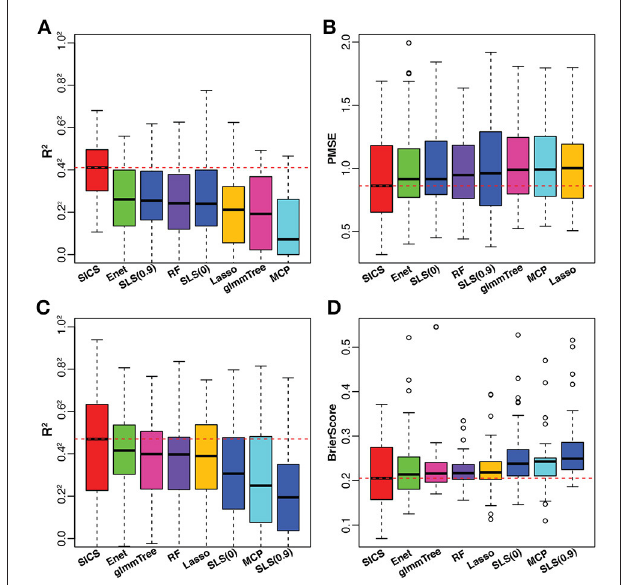
FIGURE 5 | Performance comparison on the caffeine intake data (A,B) and smoking data (C,D) . The red dashed line indicates the median value of various performance measures for SICS. SLS(0): SLS without sparsification; SLS(0.9): SLS with 90% sparsity level in the Laplacian